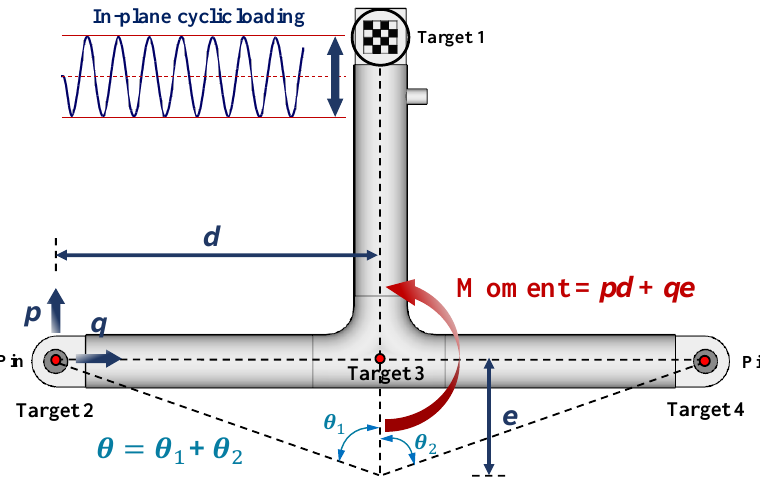
Figure 4. Measurement positions for the calculation of the moment and the deformation angle.